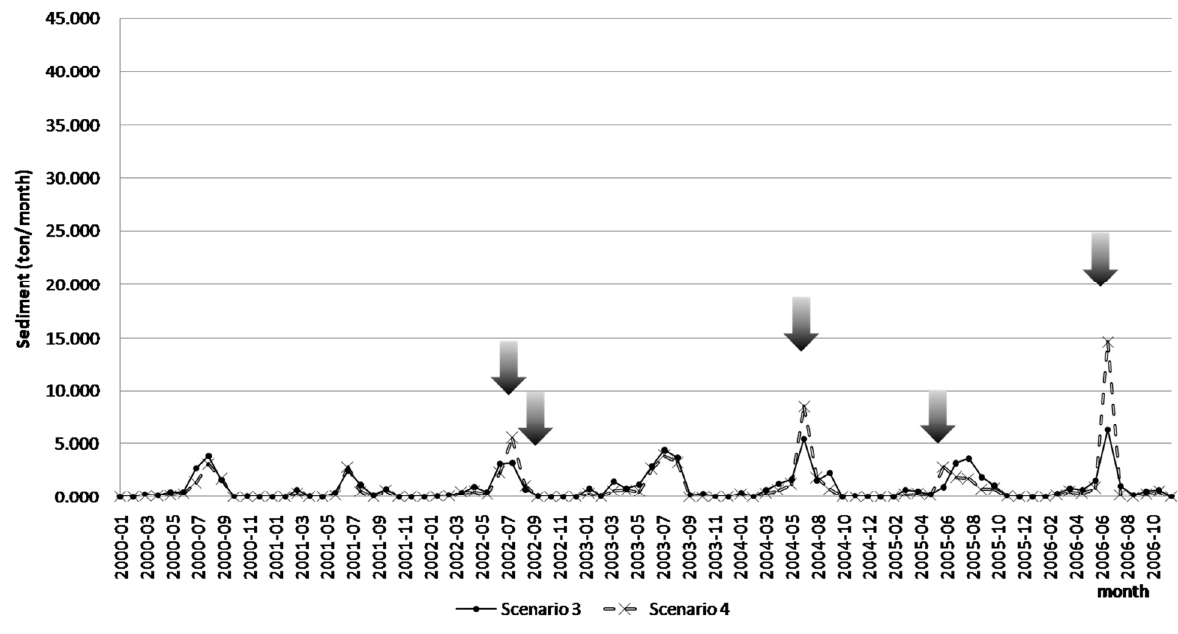
Figure 19. Comparison of Simulated Monthly Sediment for Scenarios 3 and 4.